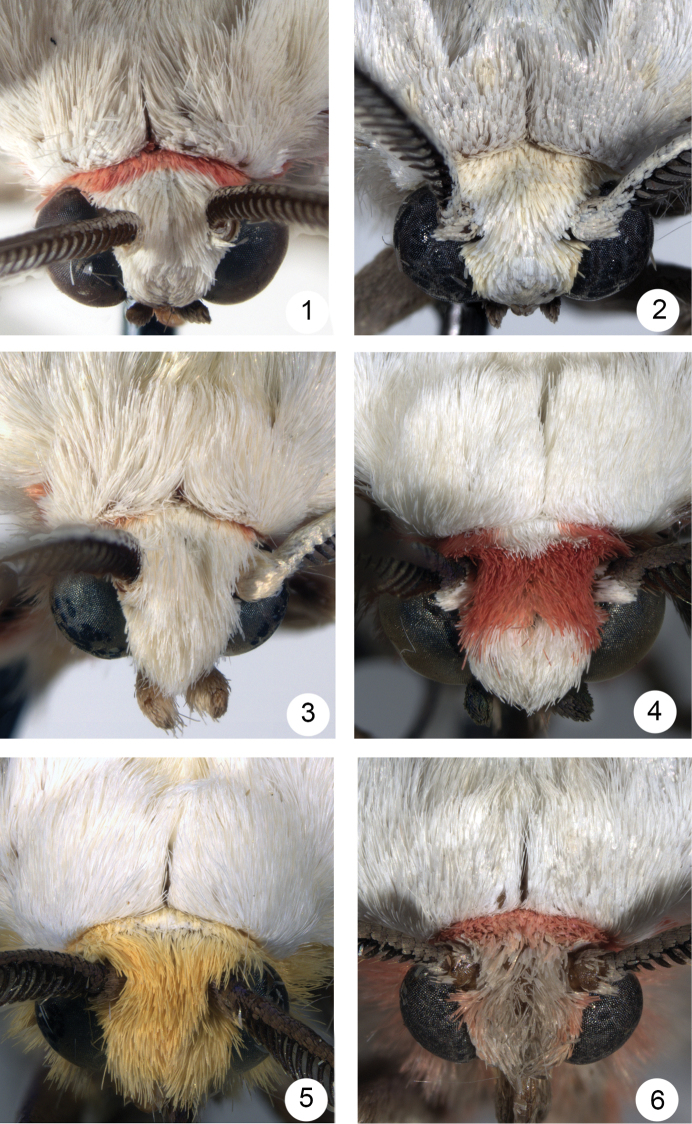
Head and thoracic colour patterns of Euchaetesnancyae and similar species. 1Euchaetesnancyae2Euchaeteshelena3Euchaetescastalla4Pygarctiaroseicapitis5Pygarctiaflavidorsalis6Pygarctialorula.